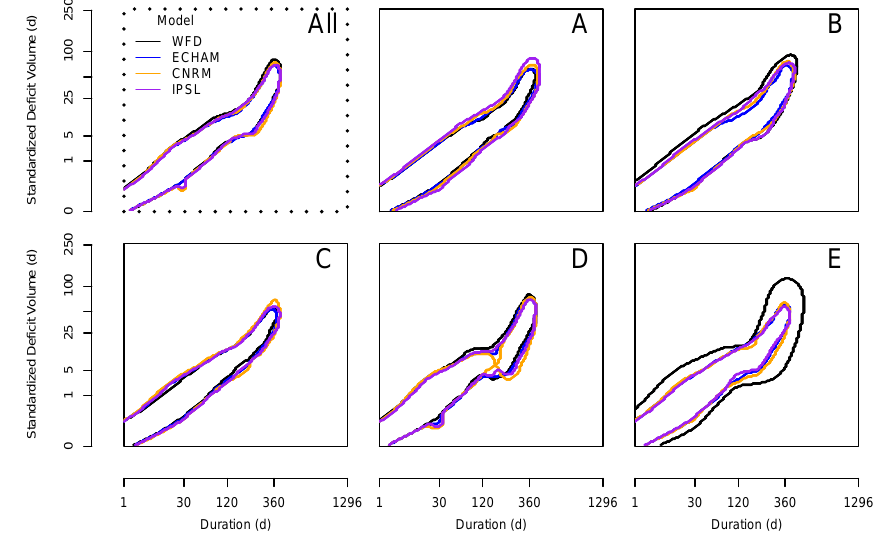
Figure 3. Bivariate probability functions for two hydrological drought characteristics (duration and standardized deficit volume) for all cli- mate types (All) and individual major climate types, Equatorial (A), Arid (B), Warm temperate (C), Snow (D) and Polar climates (E) obtained from simulations of the conceptual hydrological model, using meteorological forcing by the WATCH Forcing Data (WFD, reference) and GCMs: ECHAM, CNRM and